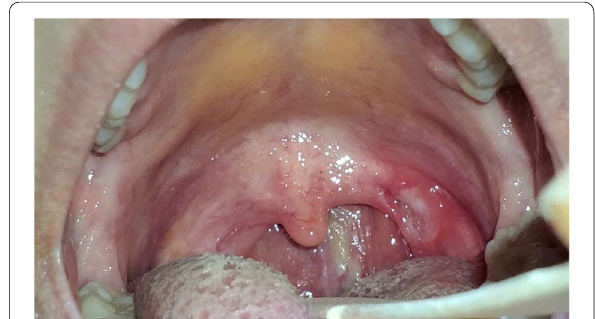
Fig. 5 An ulcer on the left lateral oropharyngeal